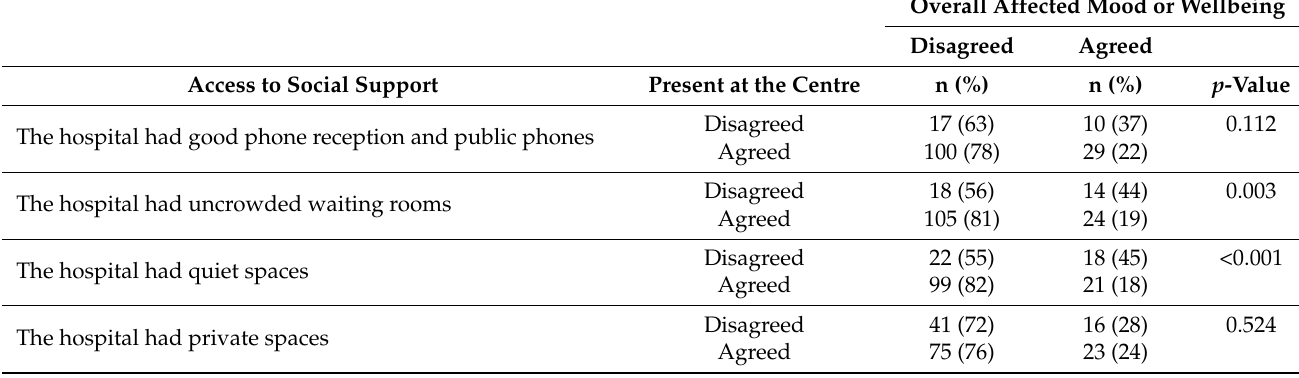
Table 3. Patient perceptions of hospital elements related to Access to Social Support and univariate associations with self-reported mood or well-being related to the overall treatment environment ( n =